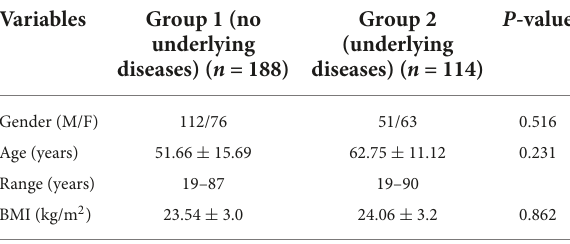
TABLE 1 Baseline characteristics of participants ( n = 302).